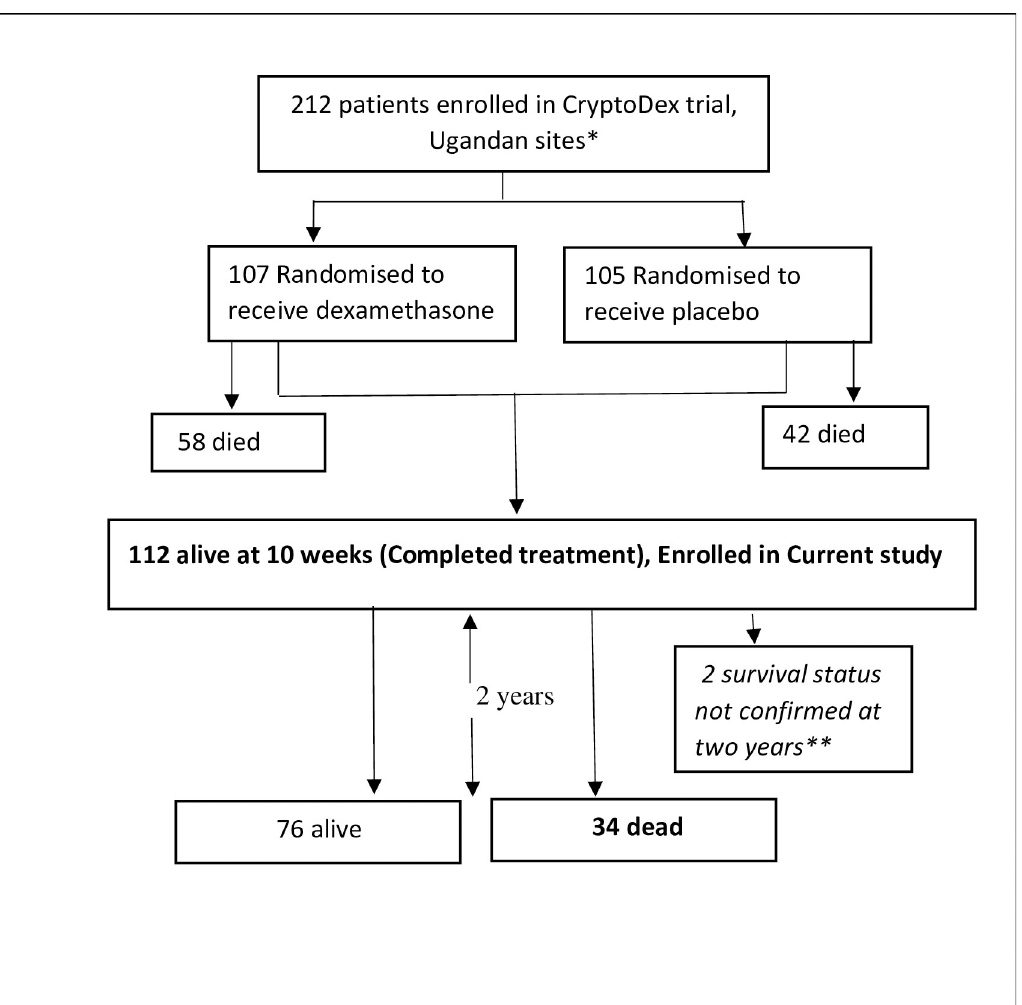
before completion of 2